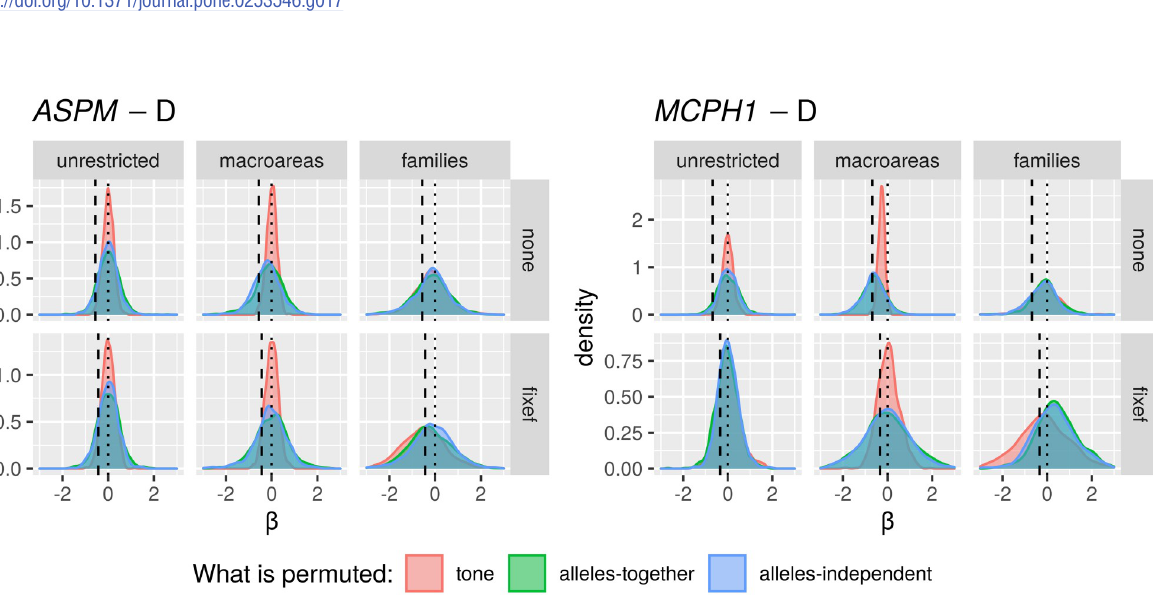
PLOS ONE | https://doi.org/10.1371/journal.pone.0253546 June 30, 2021 38 /